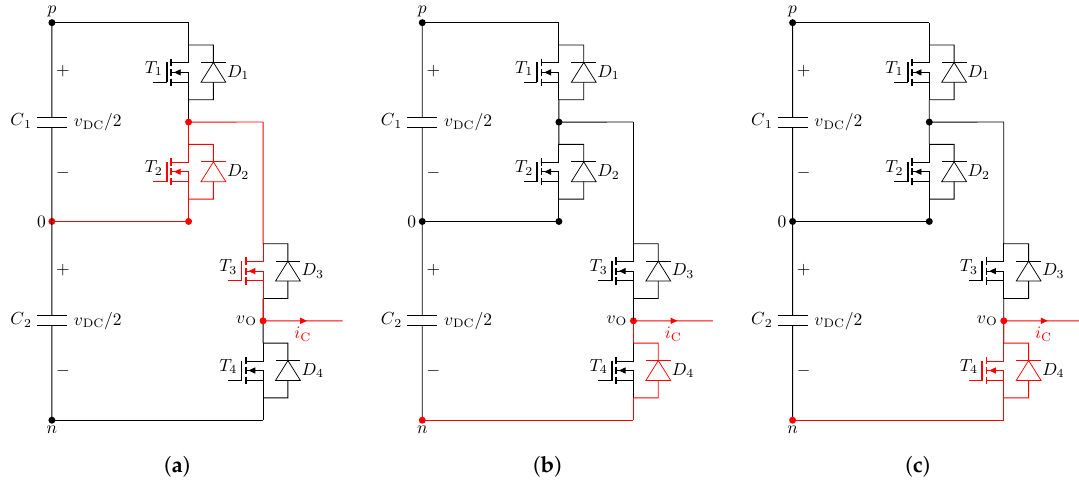
Figure 8. Current commutation, transition from switching state 0 to n for I C > 0. Current flow depicted in red. ( a ) Switching state 0 . ( b ) Blanking time (between T3 and T4 ) interval. ( c ) Switching state n